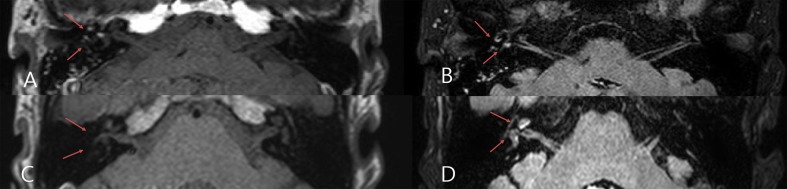
MRI findings of intra-labyinthine hemorrhage (A,B) and labyrinthis (C,D). Labyrinthitis and intra-labyrinthine hemorrhage (ILH) both show a high signal intensity on a 3D fluid-attenuated inversion recovery sequence (B,D), but the high signal intensity on the precontrast T1 sequence suggests labyrinthine hemorrhage (A) rather than labyrinthitis (C).